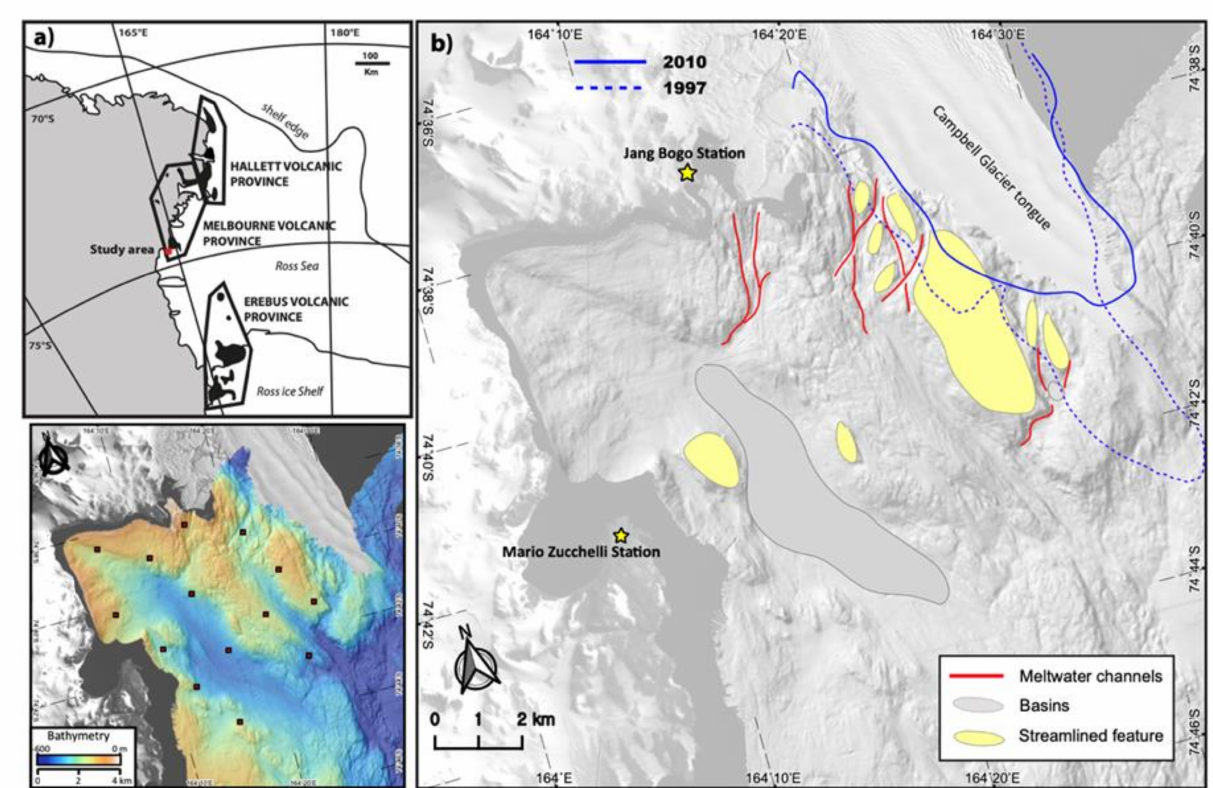
Figure 2. Multibeam swath bathymetry and geomorphology of the study area. ( a ) The study area is included in the Melbourne Volcanic Province. ( b ) The solid line is the boundary of CGT [34] and the dotted line [35].